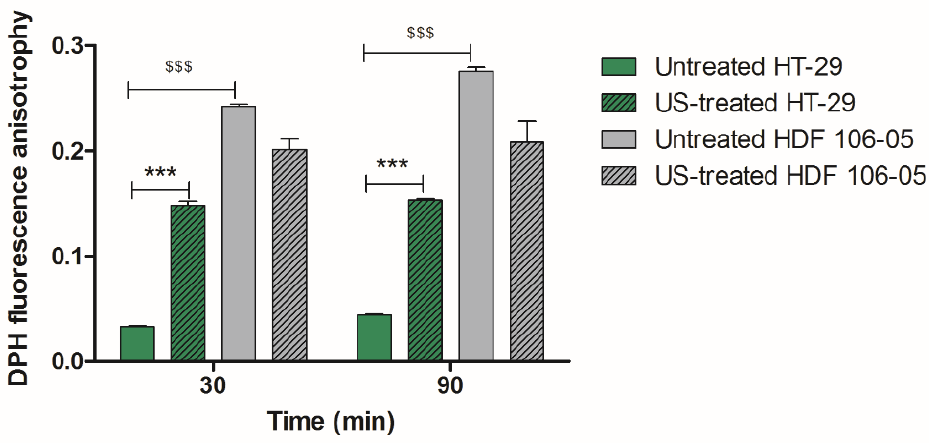
Figure 7. Effects of US exposure on cell membrane fluidity. HT-29 and HDF 106-05 cells were unexposed or exposed to US (1.5 W/cm 2 at 1.866 MHz, for 5 min). Membrane fluidity/polarization was evaluated at different time points after the treatment (30 and 90 min) by the DPH (1,6-diphenyl- 1,3,5-hexatriene) fluorescence anisotropy assay using a polarized spectrophotometer. Membrane fluidity/polarization was expressed as DPH fluorescence anisotropy. Statistically significant differ- ence of untreated HDF 106-05 versus untreated HT-29 cells: $$$ p < 0.001. Statistically significant difference versus untreated cells: *** p < 0.001.